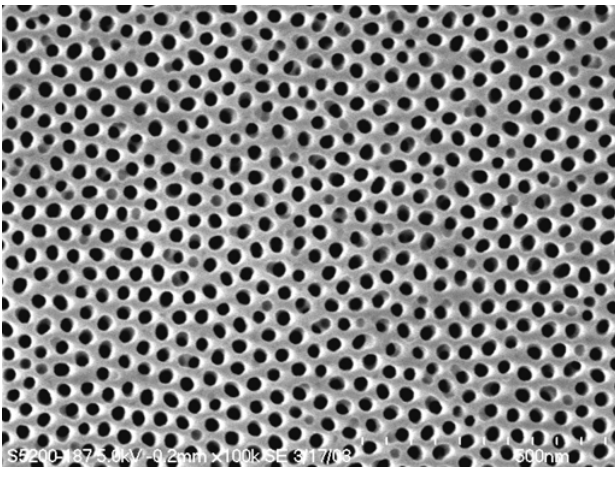
Figure 2. The SEM photograph of AAO